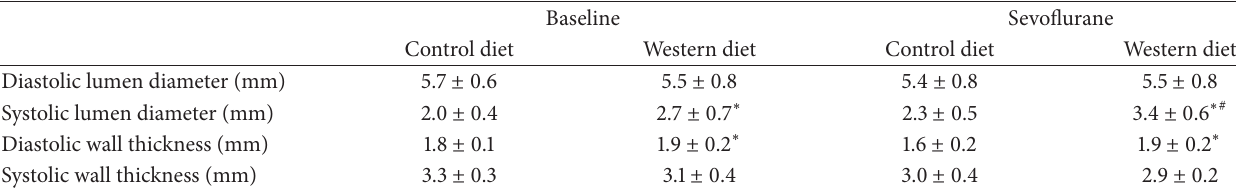
Table 2: Myocardial dimensions after 8 weeks of diet feeding during baseline and after sevoflurane